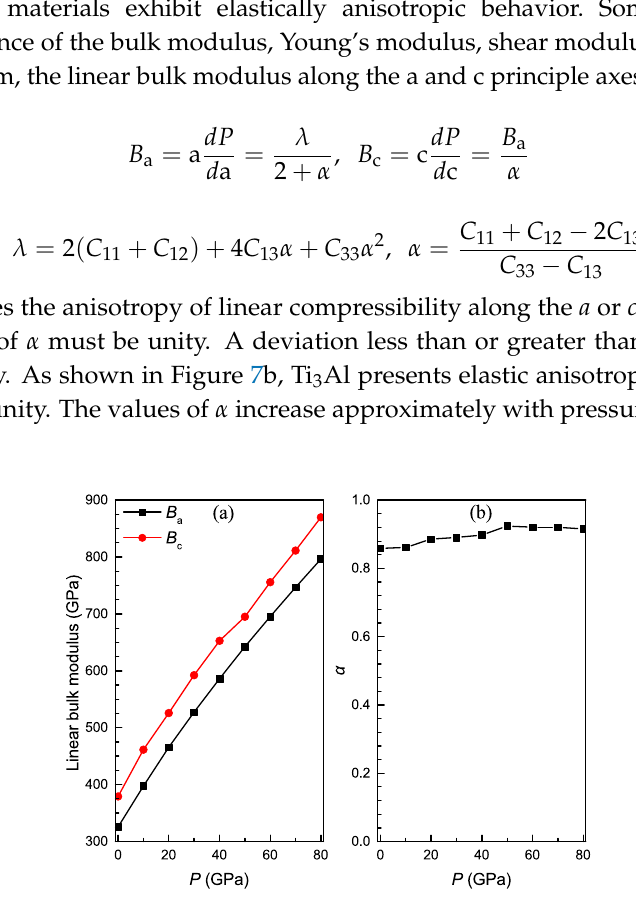
Figure 7. Linear bulk modulus along the a and c principle axes ( a ) and its anisotropy α ( b ) as a function of pressure for Ti 3